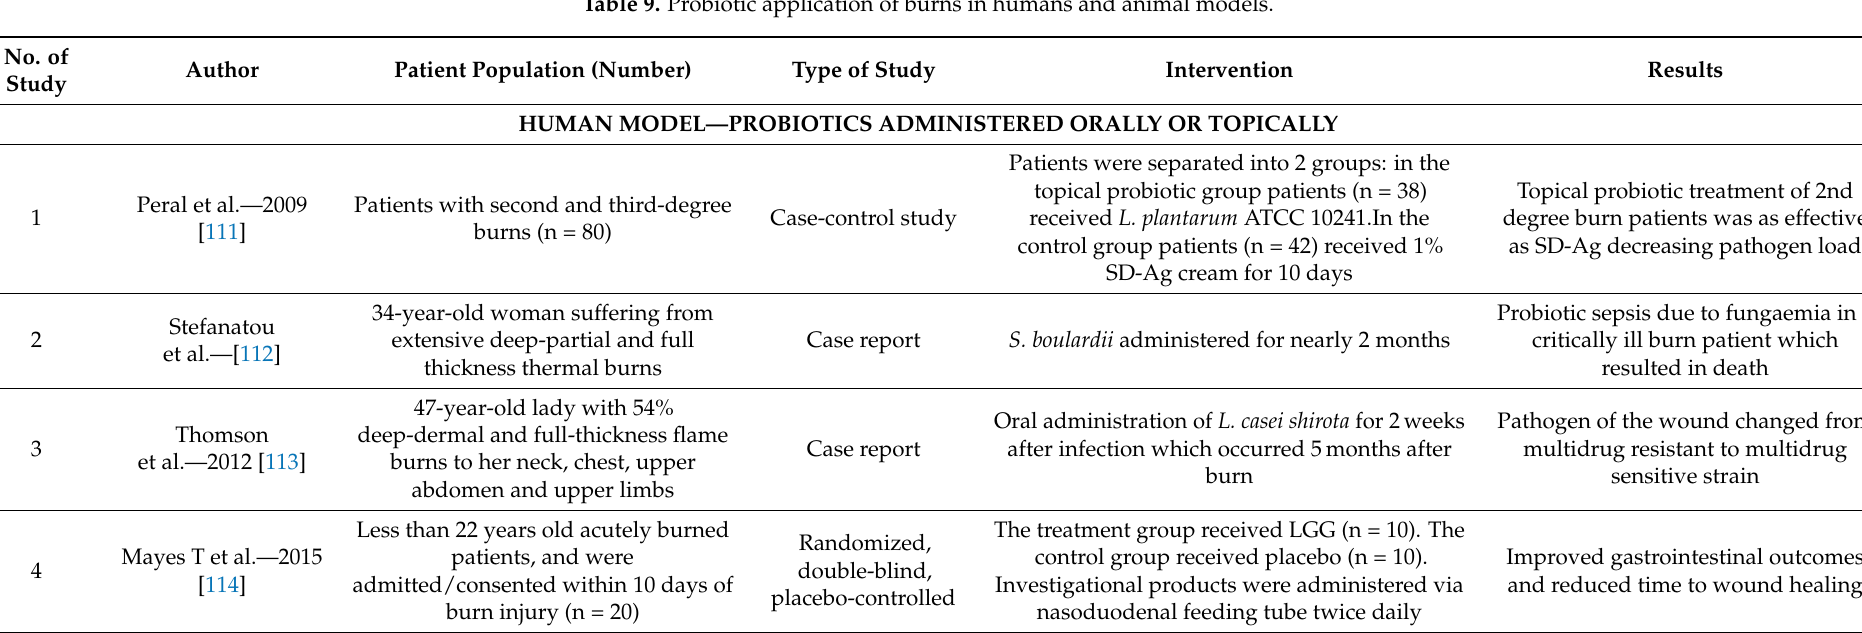
Table 9. Probiotic application of burns in humans and animal